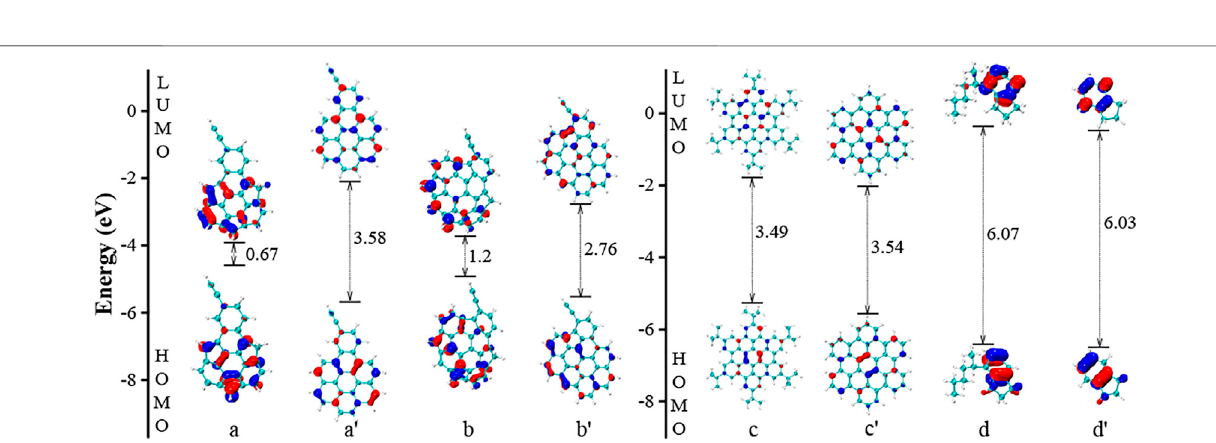
Frontiers in Mechanical Engineering |